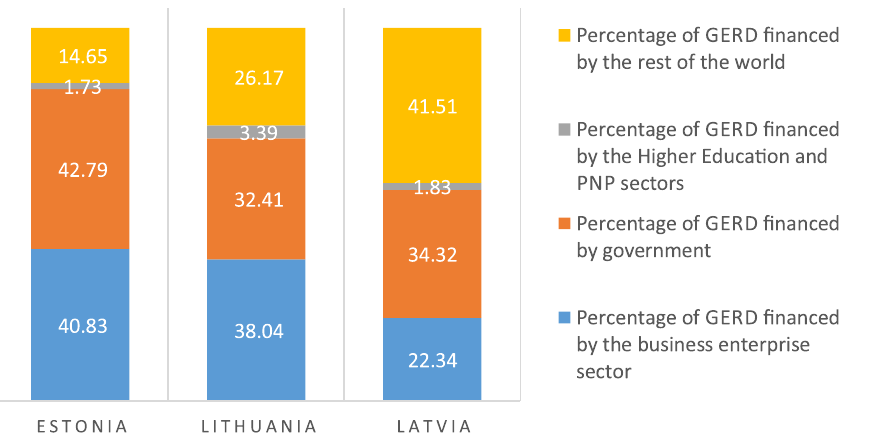
Figure 11. Structure of R&D financing in Estonia, Lithuania and Latvia in 2018. Source: Main Science and Technology Indicators. https://stats.oecd.org/Index.aspx?DataSetCode=MSTI_PUB# (accessed on 10 June